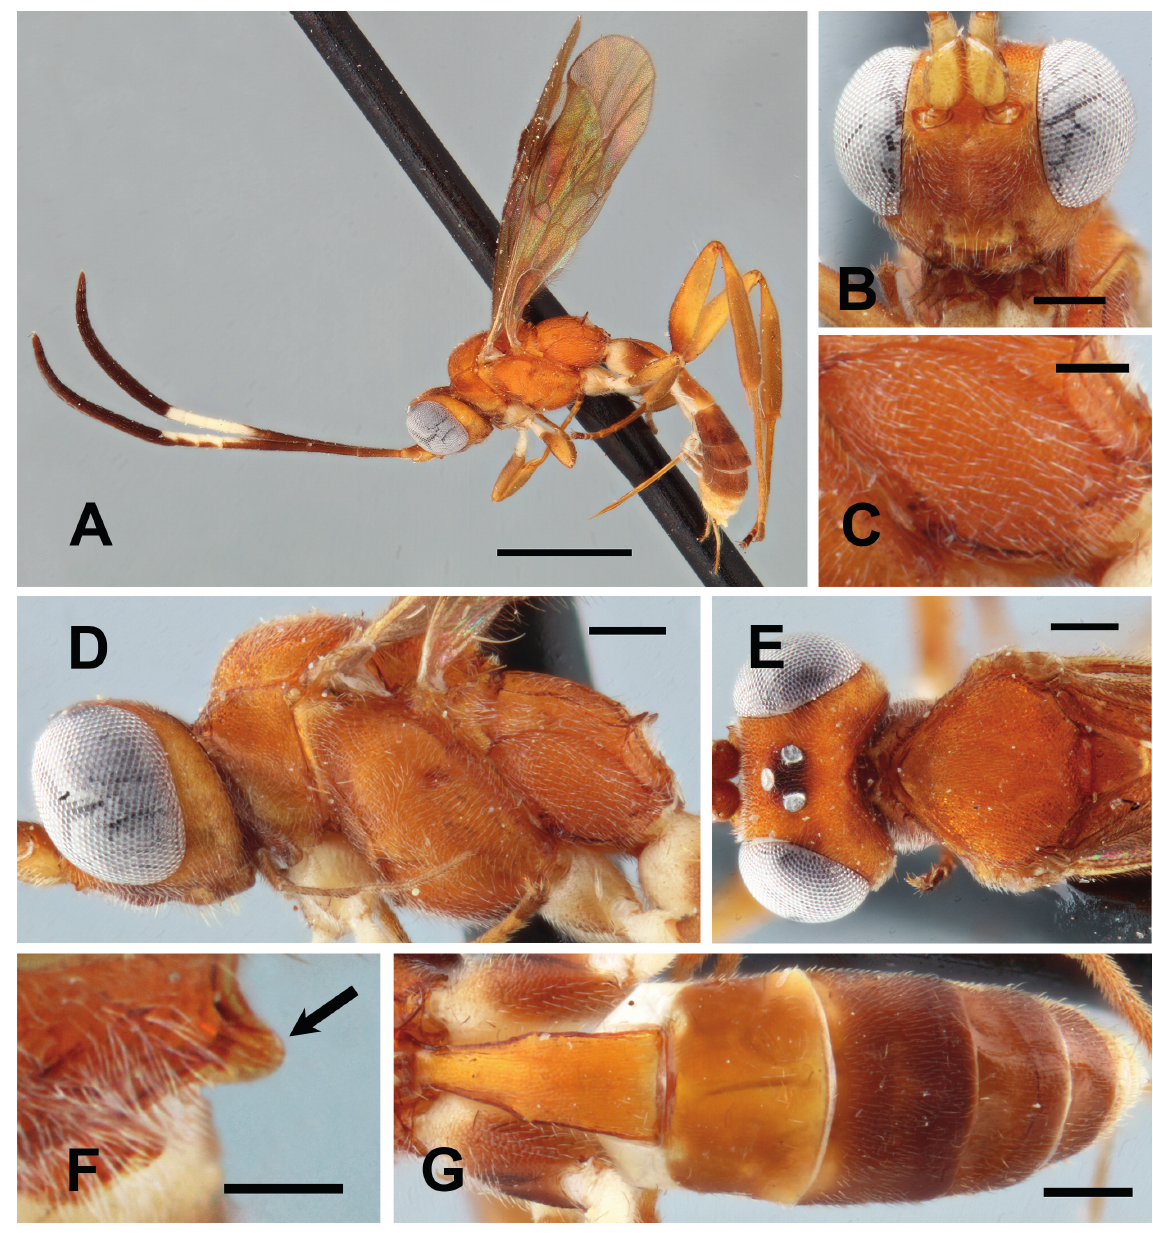
Fig. 2. Morphology of Handaoia cuscoensis Bordera sp. nov., holotype, ♀ (AEIC). A . Habitus, lateral view. B . Head, front view. C . Metapleuron. D . Head and mesosoma, lateral view. E . Head and mesoscutum, dorsal view. F . Propodeum (arrow: propodeal apophysis). G . Metasoma, dorsal view. Scale bars: A = 1 mm; B, D–E, G = 0.2 mm; C, F = 0.1